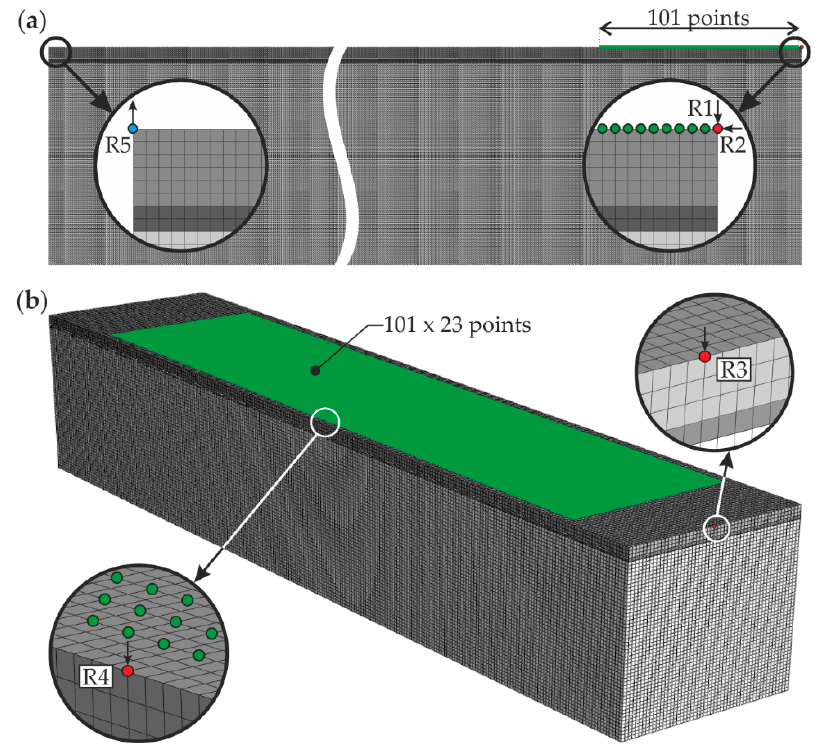
Figure 4. Numerical models for specimen #1: ( a ) 2-D plane model and ( b ) 3-D spatial model.